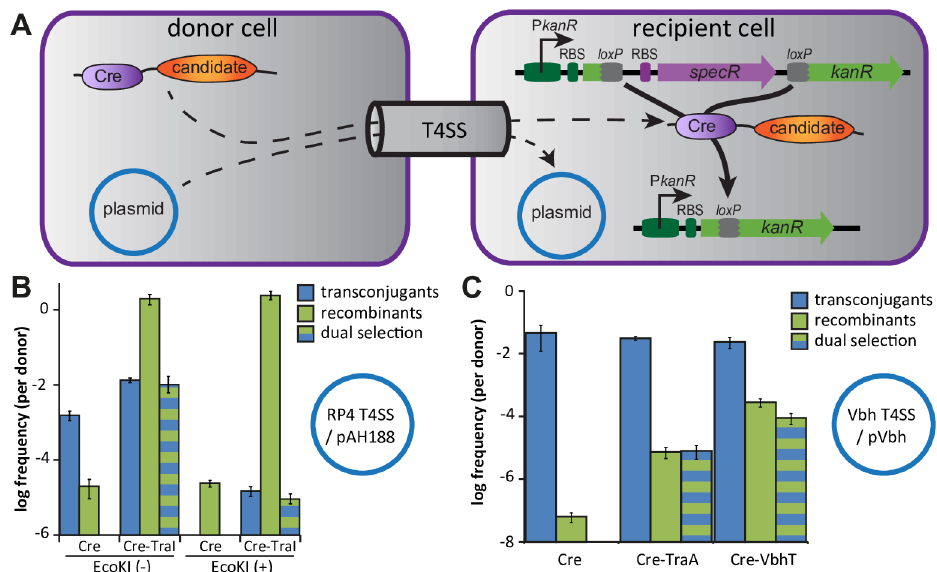
Fig 5. A novel variantof CRAfTdetectsthe interbacterialtransferof VbhT. (A) The schemeoutlinesbasic principlesof the new CRAfTvariantthat wedevelopedas part of this study. Interbacterial proteintransferof Cre fusionsis detectedthroughthe switchfrom spectinomycinresistance(purple)to kanamycinresistance(green). Conjugative plasmidtransfercan be assayedin parallel(blue)by selectionfor antibioticresistanceencodedon reporterplasmidpAH188(chloramphenicolresistance; E . coli matings)or pVbh(gentamicin resistance; Bartonella matings). (B) Conjugative transferof pAH188andCRAfT signalfor the translocationof a Cre-TraI relaxasefusionthroughthe RP4T4SS wereassayedusing E . coli K-12BW25113(lackingEcoKI) or E . coli K-12 MG1655 (with functionalEcoKI) as recipients.(C) Thetransferof Cre fusedto the TraA relaxaseof pVbhor the catalytically inactiveH136Amutant of VbhTweretestedin matingsof B . schoenbuchensis with B . henselae carryingtheCRAfT sensormodule;conjugationof pVbhwas assayedin parallel.Datapointsanderror barsin (B) and(C) representmeanandstandard deviationof threeindependent experiments. Transconjugantsare recipientcellsthat havereceivedpAH188(B) or pVbh(C), andrecombinants denoterecipientcellsthat switched resistanceof the CRAfTsensordueto successful transferof Crefusionproteinsor, muchrarer,spontaneous recombinationof the loxP sites.